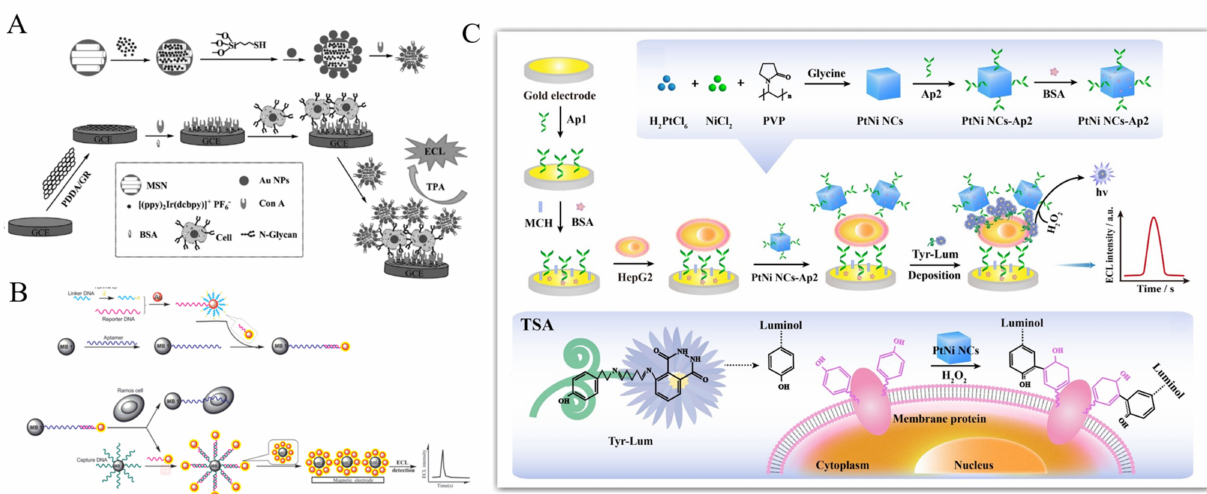
Figure 14. ( A ) Schematic representation of fabrication of the Con A@Au/Ir-MSN nanoprobe, and assembly of the electrode interface and the sandwich-like nanoarchitectured electrode geometry for cytosensing [231]. Copyright 2014 Wiley-VCH. ( B ) Schematic representation of the ECL cytosensor based on Ru(II) complex-functionalized aptamers, AuNPs and MBs [238]. Copyright 2012 Wiley-VCH. ( C ) Schematic representation of the prepared ECL cytosensor for HepG2 cells detection based on TSA strategy [239]. Copyright 2020 Elsevier